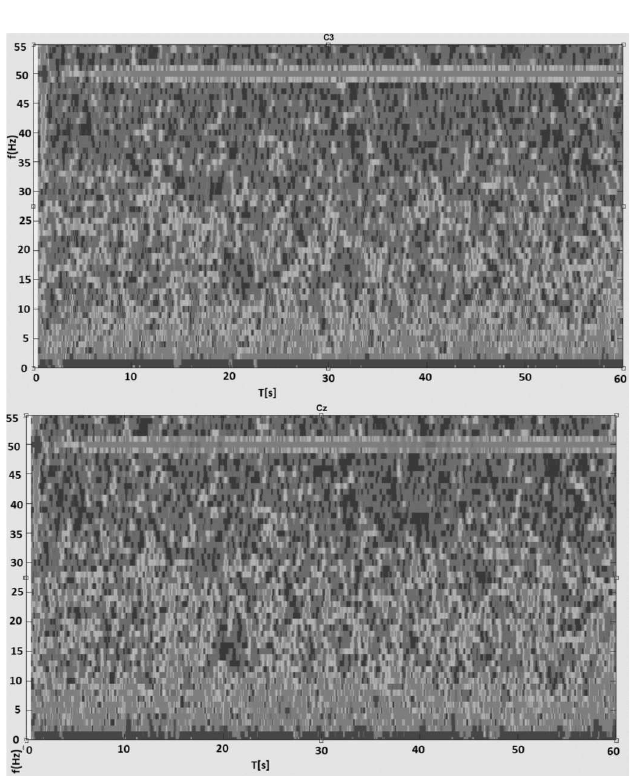
Figure 4. Example of excess Theta waves – spectrogram, sample 1